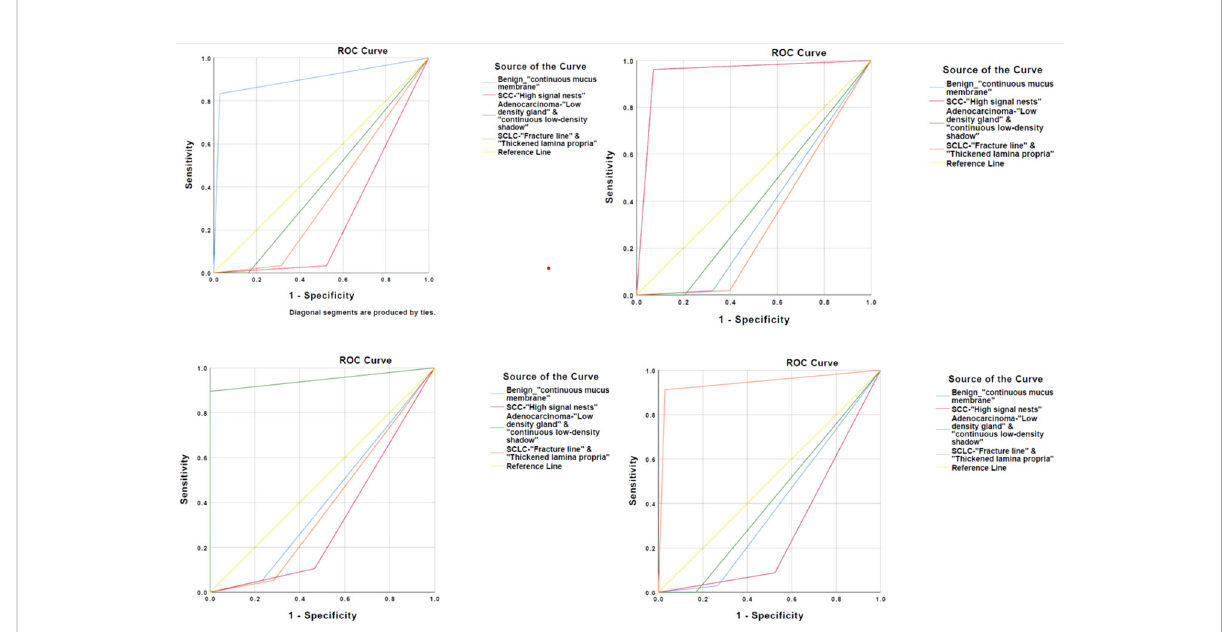
FIGURE 5 Four main OCT image characteristics have a high degree of differentiation to predict the corresponding